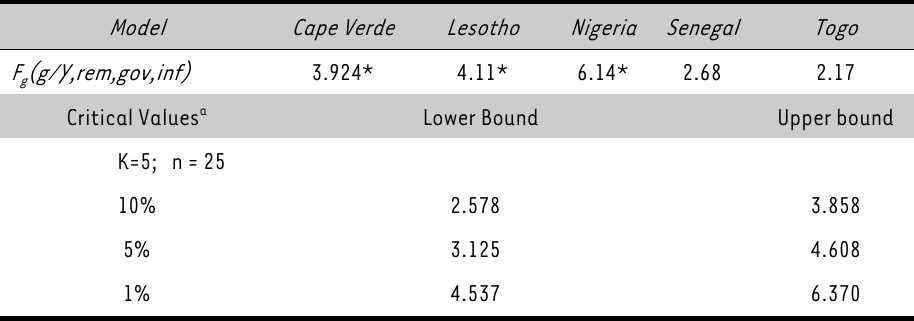
TABLE 3: ARDL Bounds test for cointegration Model Cape Verde Lesotho Nigeria Senegal Togo F (g/Y,rem,gov,inf) 3.924* 4.11* 6.14* 2.68 2.17 g Critical Values a Lower Bound Upper bound K=5; n = 25 10% 2.578 3.858 5% 3.125